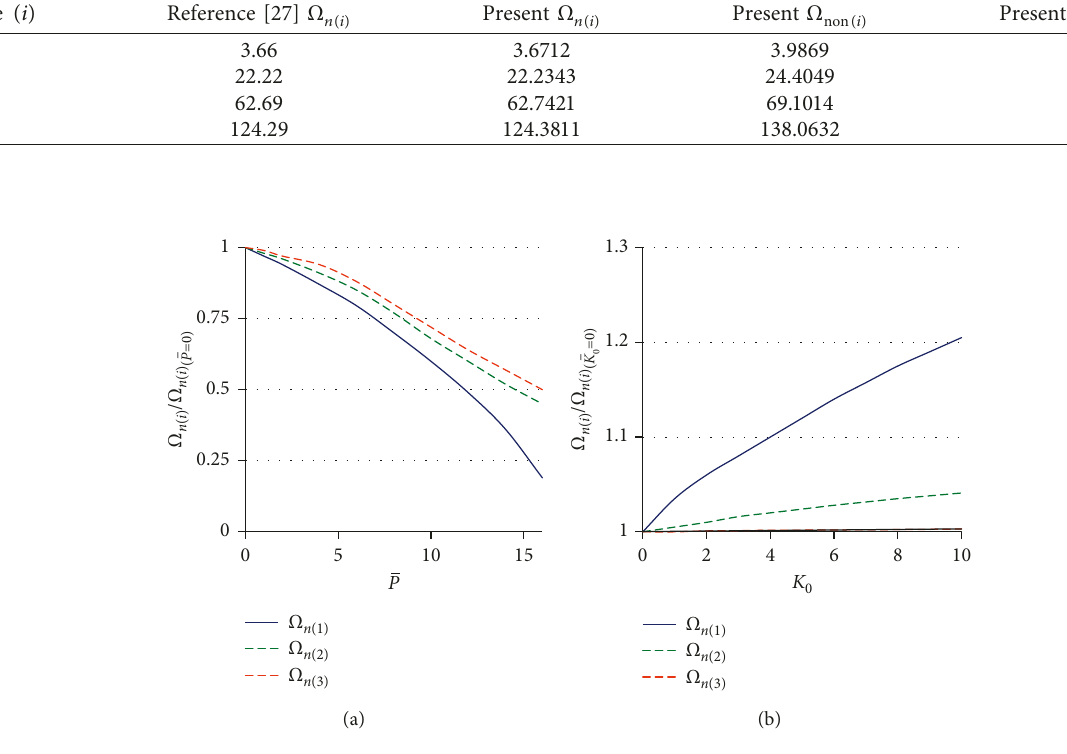
Table 2: Natural frequencies of the cantilever beam on an elastic foundation with P � 0 and K